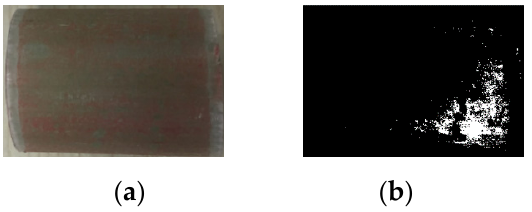
Figure 24. Anatomy observation: (a) Core rod without sheath; (b) Binarized image of the core rod.